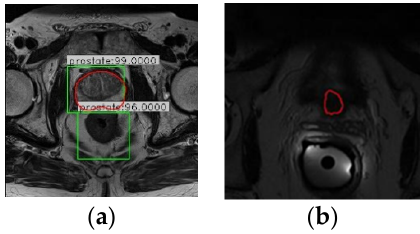
Figure 6. Sample images with ( a ) multiple object bounding boxes and ( b ) without object bounding box (red: the true contour of the prostate, green: bounding boxes detected by the network that exceed a threshold of 0.80).